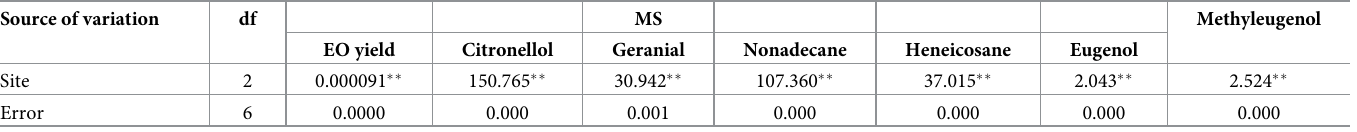
Table 3. ANOVA of the effect of crop site on yield and some dominant and important compounds of R . damascena EO. Source of variation df